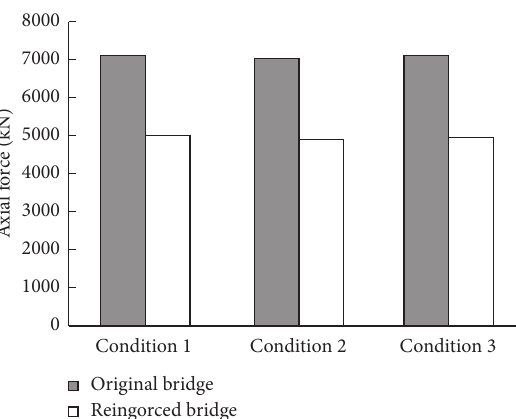
Table 8: Comparison of peak values of internal force at the fixed end of the bridge before and after reinforcement. Bridge status Before reinforcement After reinforcement